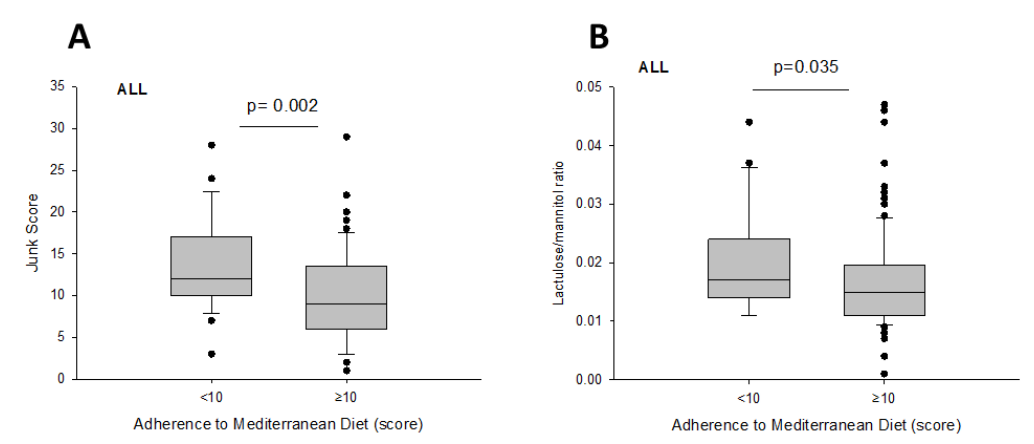
Figure 7. Di ff erences in ‘Junk Score’ ( A ) and small intestinal permeability ( B ) according to adherence to Mediterranean Diet.